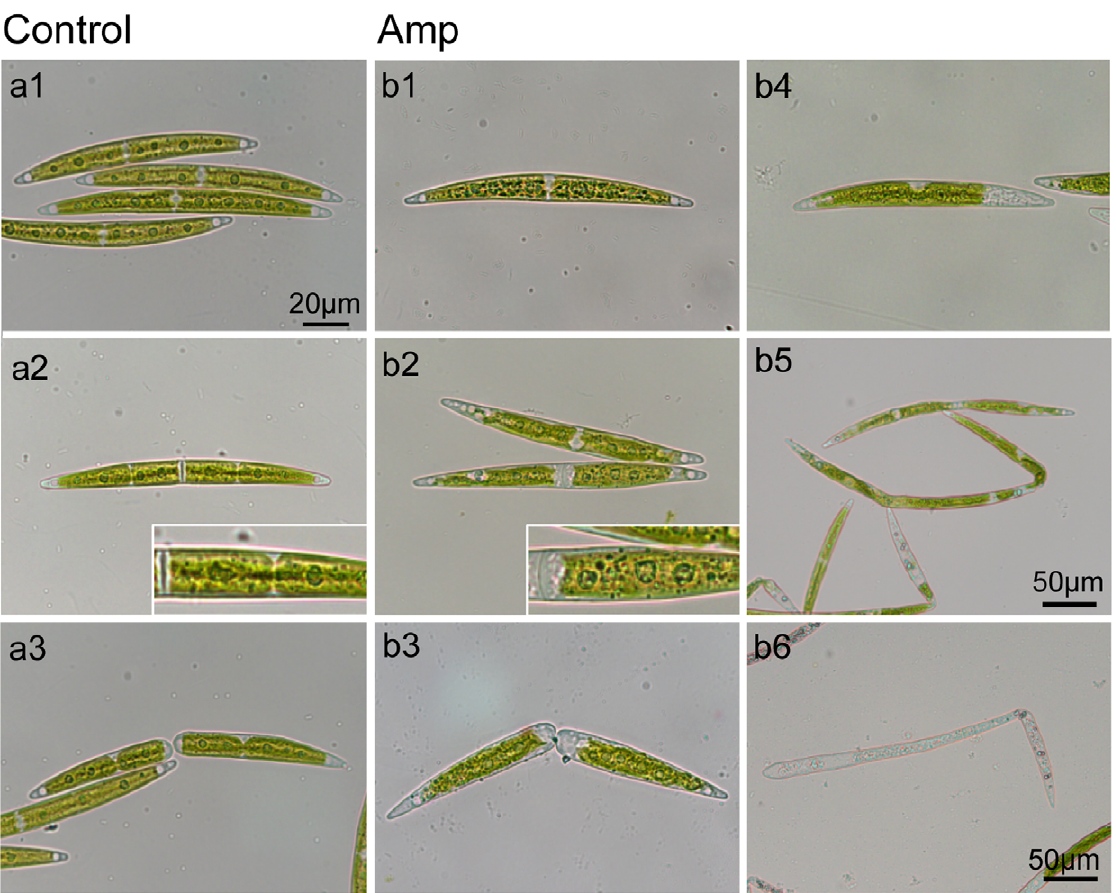
Figure 4. Representative micrographs of ampicillin-treated cells. For controls, dividing cells in the medium without ampicillin are shown (a1– 3). When crescent-shaped cells (a1) enter the division process, chloroplasts started to divide (a2). After septum formation, two new semicells with two chloroplasts appeared (a3). In the medium with 100 m M ampicillin (b1–6), various types of cells were observed. There were normal crescent-shaped cells with two chloroplasts (b1), dividing cells without chloroplast division (b2), divided semicells with only one chloroplast (b3), crescent-shaped cells with one chloroplast (b4), long cells with irregular chloroplasts (b5) and dead cells (b6). The magnification in those photos without a scale bar is the same as that in